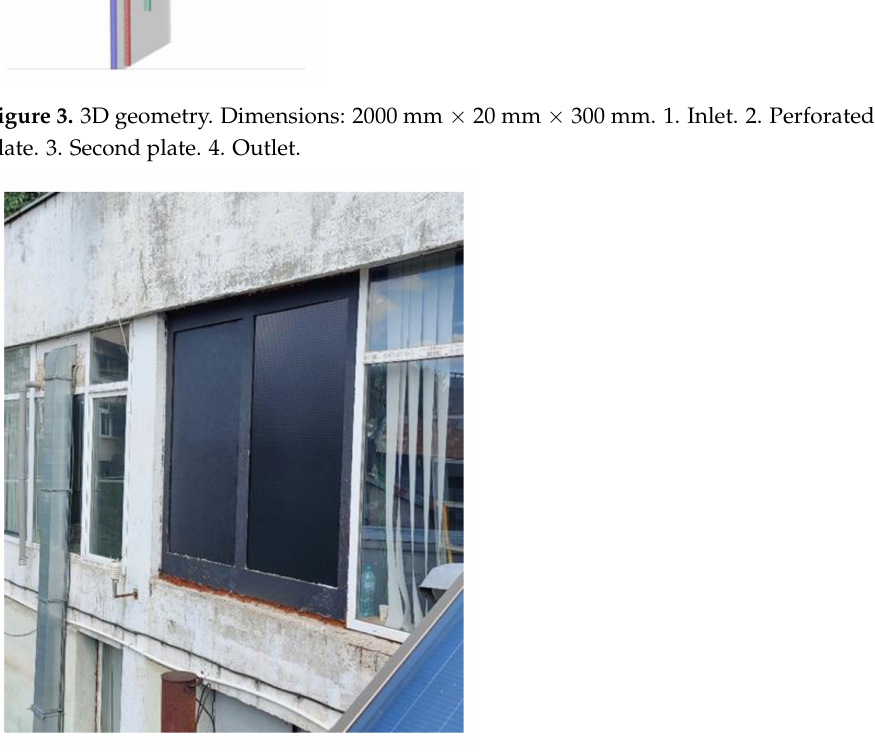
Figure 4. Building integrated Transpired Solar Air Collectors. TSC on the left and DSTSC on the